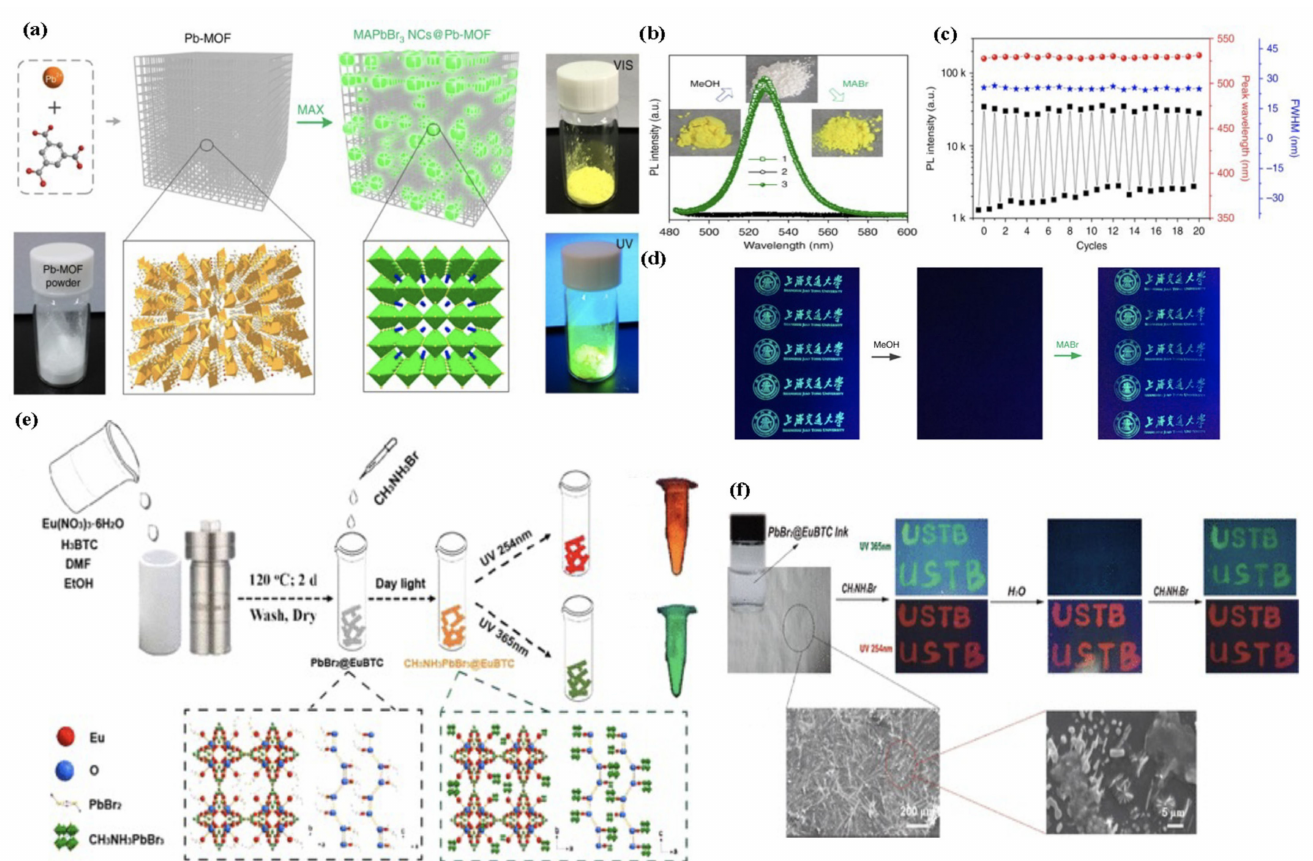
Figure 6. ( a ) Schematic of the conversion process. MAX represents the halide salt (CH 3 NH 3 X, X = Cl, Br, or I). The green spheres in the matrix represent the MAPbBr 3 NCs. The two black boxes show 3D crystal structure of the Pb-MOF (left) and MAPbBr3 (right). The Pb coordination polyhedra (the Pb atoms are coordinated by nine O atoms, in which two O atoms of one carboxylate coordinate to a Pb and also bridge two adjacent Pb atoms) and MAPbBr 3 is represented in orange and green, respectively. Other atom colour schemes: C = grey, O = red, N = blue, Br = yellow. H-atoms have been omitted